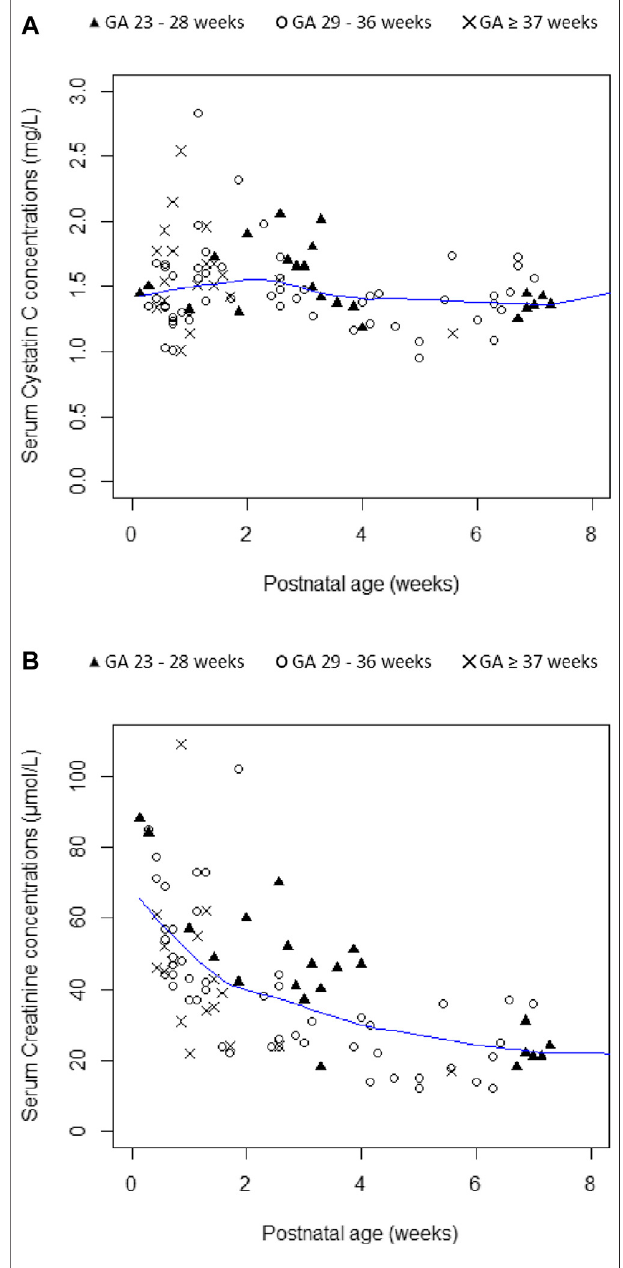
FIGURE 2 | Plots of Serum Cystatin C concentrations (A) and Serum Creatinineconcentrations (B) according togestational age (GA) and postnatal age. Smooth lines are represented in blue